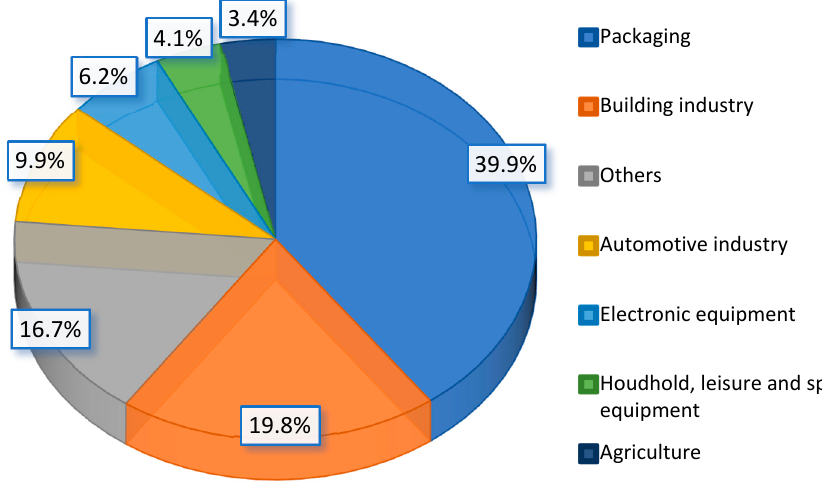
Figure 6. The contribution of different industries in plastics demand in Europe in 2018. Own work based on data published in [78].